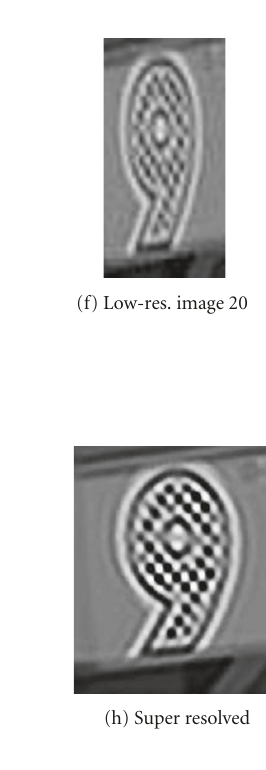
Figure 1: Examples of simultaneous MAP super-resolution. (a), (b) Two close-ups from a 30-frame digital camera sequence; (c) first image interpolated into high-resolution frame; (d) simultaneous super-resolution output; (e), (f) two close-ups from a set of 29 DVD movie frames; (g) first image interpolated into high-resolution frame (at corrected aspect ratio); (h) simultaneous super-resolution